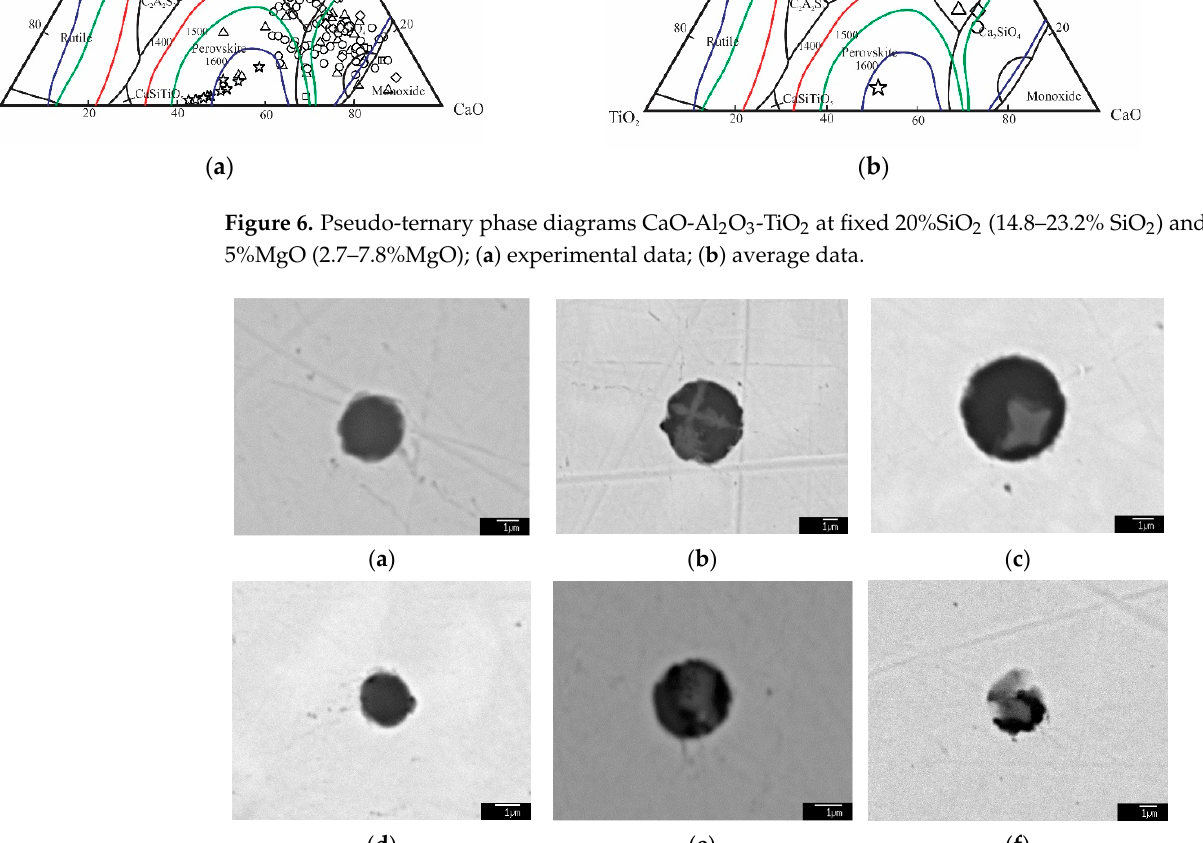
Figure 8. The formation and evolution mechanism of CaO-Al 2 O 3 -SiO 2 -(MgO)-TiO 2 inclusion during the whole refining process. 3.4. Formation Mechanism and Evolution of CaO-Al 2 O 3 -SiO 2 Inclusion There are generally two morphology types of CaO-SiO 2 -Al 2 O 3 inclusions as shown in Figure 9. One is a single-phase inclusion with a smooth surface, and the other has a rough surface. These two types of CaO-SiO 2 -Al 2 O 3 inclusions have different chemical composi- tions as shown in Table 3. The basicity CaO/SiO 2 of them is similar at about 1.9–2.0. The difference is mainly the component of Al 2 O 3 : Al 2 O 3 of the inclusion in Figure 9a is 24.5% while that of the inclusion in Figure 9b is only 2.8%, so the inclusion in Figure 9b can be defined as CaO-SiO 2 . The chemical composition distribution of CaO-SiO 2 -Al 2 O 3 inclusions in steel samples taken from different stages of industrial manufacturing was projected into CaO-Al 2 O 3 -SiO 2 ternary phase diagrams, as shown in Figure 10.